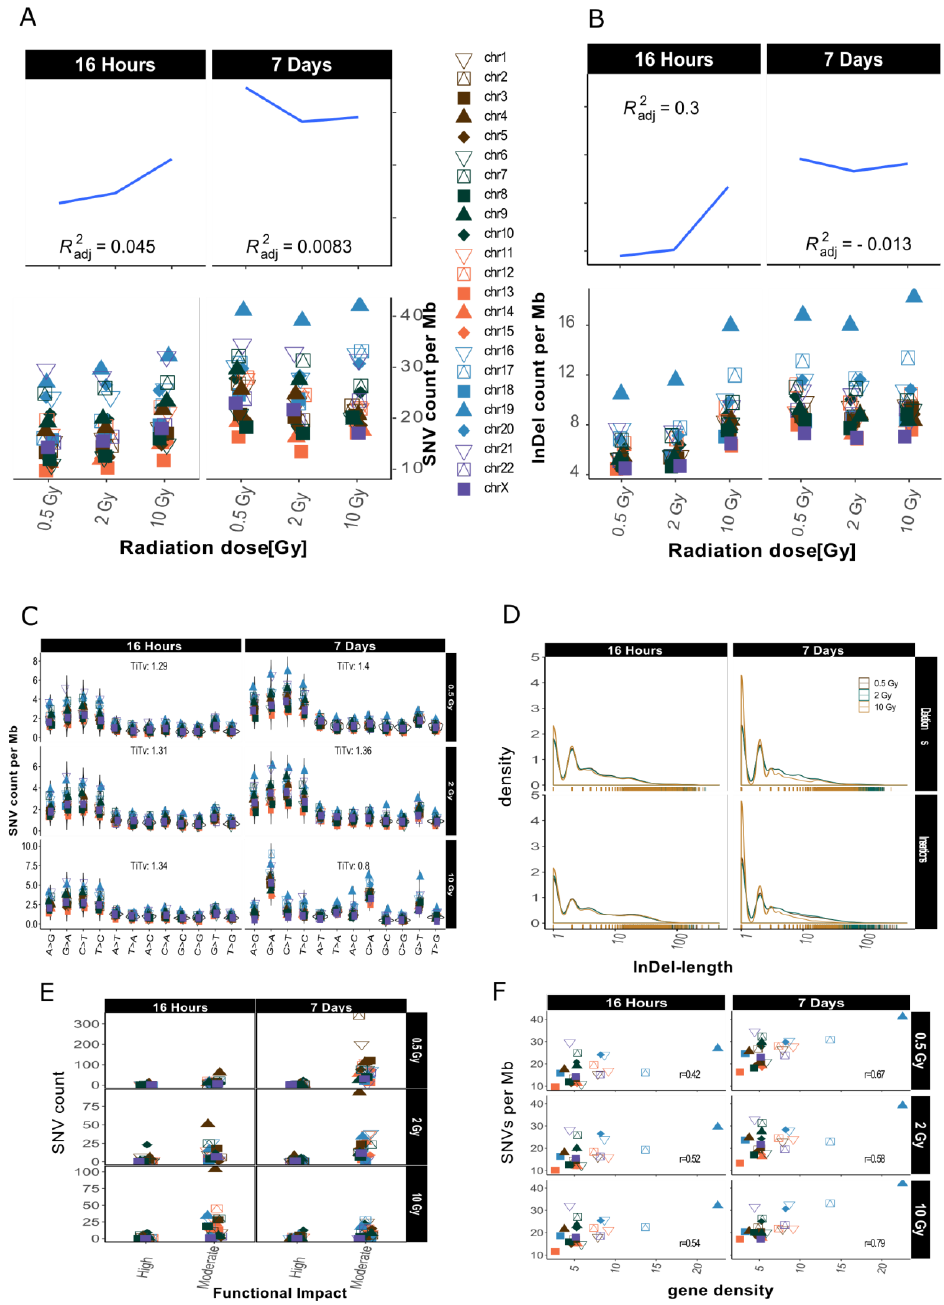
Figure A2. Overview for IR-induced SNV accumulation in genome dataset 2. Accumulation of SNVs per Mb (( A ), lower panel) and InDels per Mb (( B ), lower panel) per chromosome is shown together with the corresponding trends with adjusted root mean square (upper panels) for one sample with lower coverage (10Gy/7d) a scaling factor of 2.5 was used for visualization purposes (graphs A and B only). ( C ): SNV types, i.e., as transitions (Ti) and transversions (Tv) per MB per chromosome and Ti/Tv values for each sample. ( D ): Distribution of insertions and deletions with respect to size. ( E ): SNV count per chromosome with respect to functional impact (HIGH and MODERATE functional consequences only). ( F ): SNVs per Mb per chromosome with respect to relative chromosomal gene density. Gene density was computed based on hg19 (GRCh37) using the custom gene set (excluding predicted genes) described b